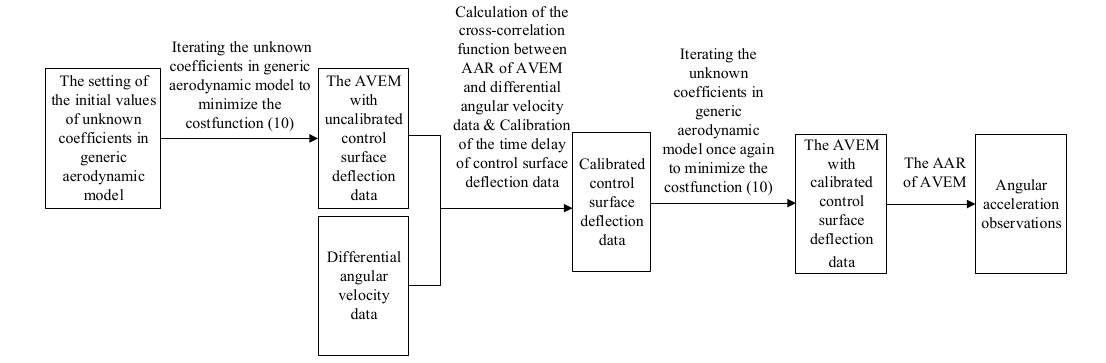
Figure 2. The flow diagram of angular acceleration estimation method.